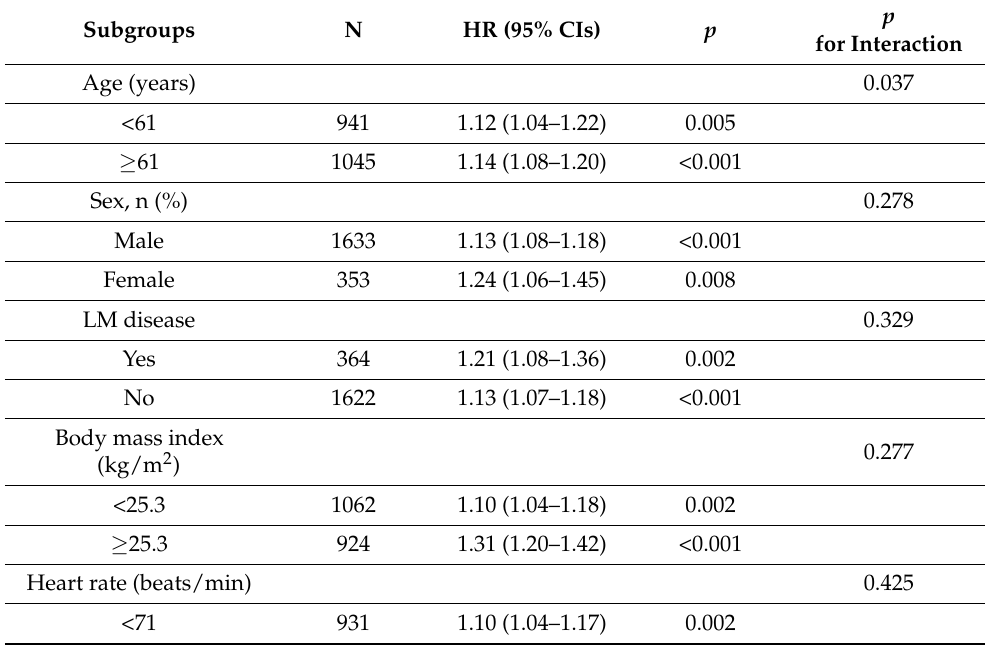
Table 4. Subgroup analysis of associations between RDW and MACE.